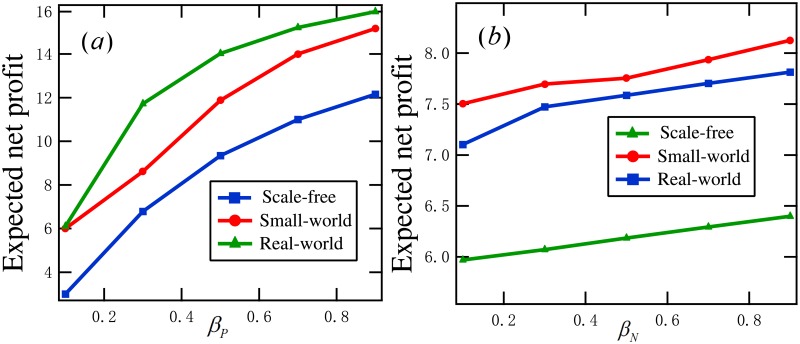
Experimental results in Example 4: (a) the optimal expected net profits for βD = 0.4 and βP ∈ {0.1, 0.3, ⋯, 0.9}, (b) the optimal expected net profits for βP = 0.4 and βD ∈ {0.1, 0.3, ⋯, 0.9}.